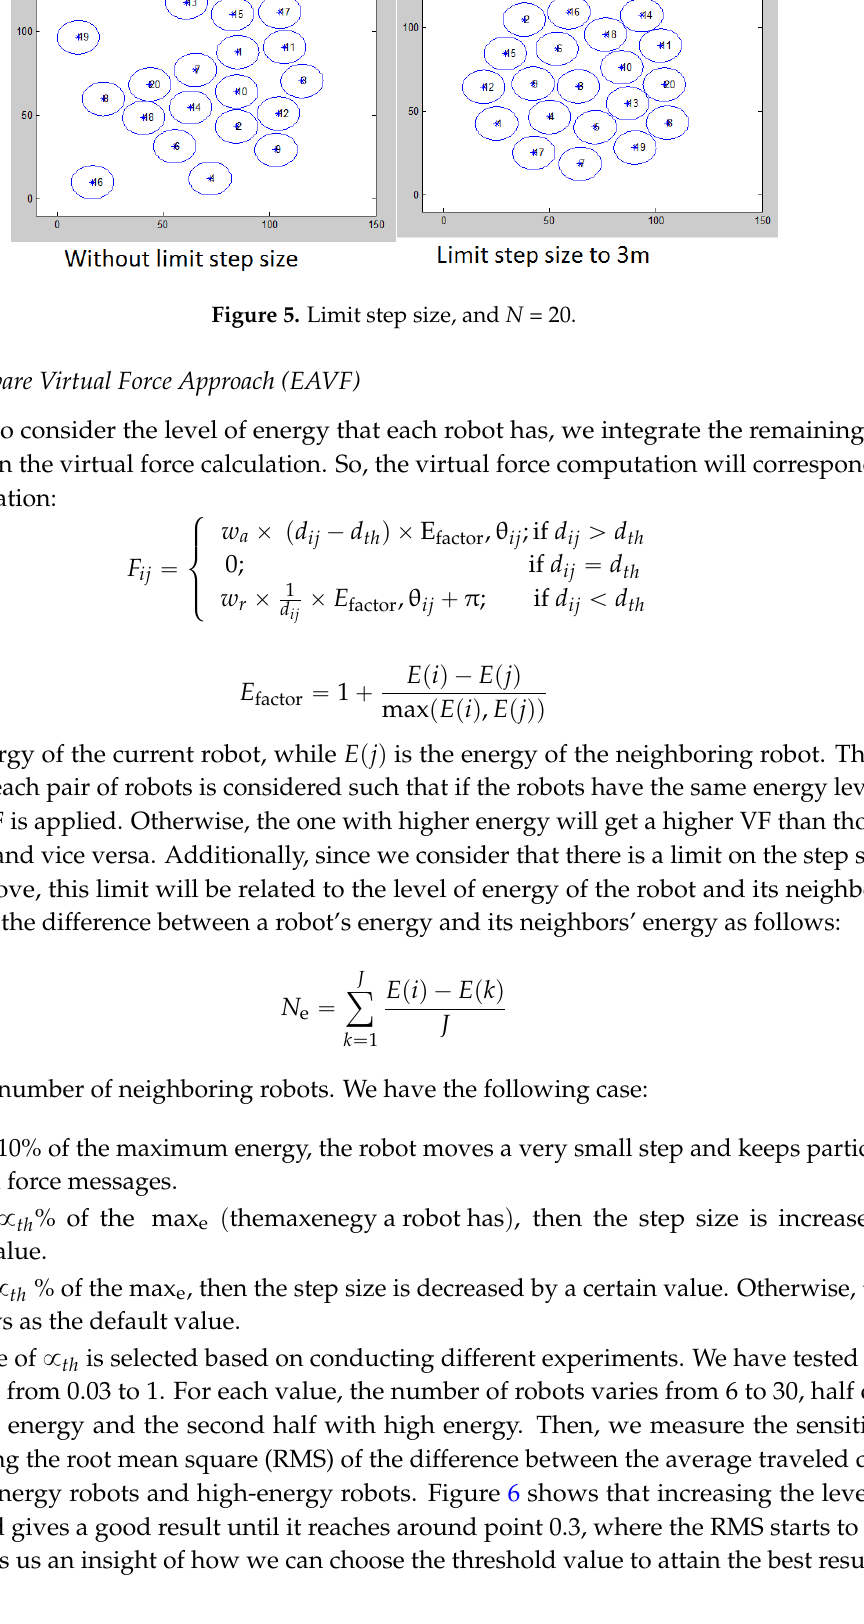
Figure 4. The effect of different settings of (cid:1875) (cid:3045) , N =50, and N =15.